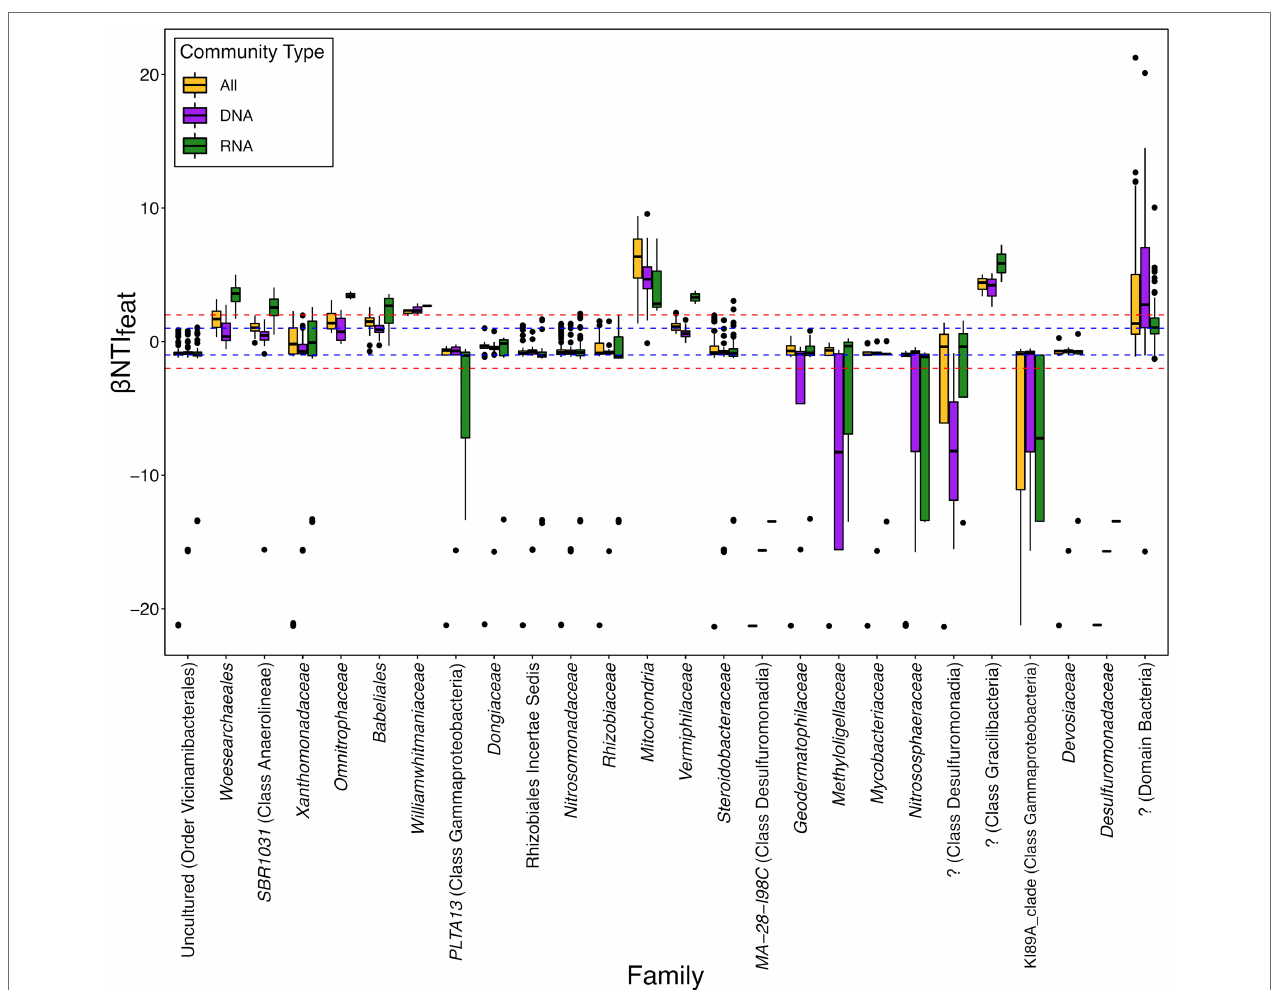
FIGURE 3 | Distribution of feature-level β -nearest taxon index ( β NTI feat ) values for ASVs belonging to the Family-level taxonomic groups which contribute to either convergence or divergence on average. Some of these taxonomic groups only have a single ASV (e.g., Family MA-28-I98C), whereas other groups have many more (the top two were the unclassified Bacteria with 454 ASVs and the Nitrosomonadaceae with 147 ASVs). “DNA” represents the β NTI feat values for the total community (defined by the 16S rRNA gene amplicon results), “RNA” represents the β NTI feat values for the putatively active community (defined by the transcribed 16S rRNA gene amplicon results), and “All” represents β NTI feat values calculated from the complete community (both DNA and RNA combined). The blue dashed line at +1 and − 1 represents the “Contributes” threshold outlined in Figure 1 , while the red dashed line at +2 and − 2 represents the “Significantly Contributes”